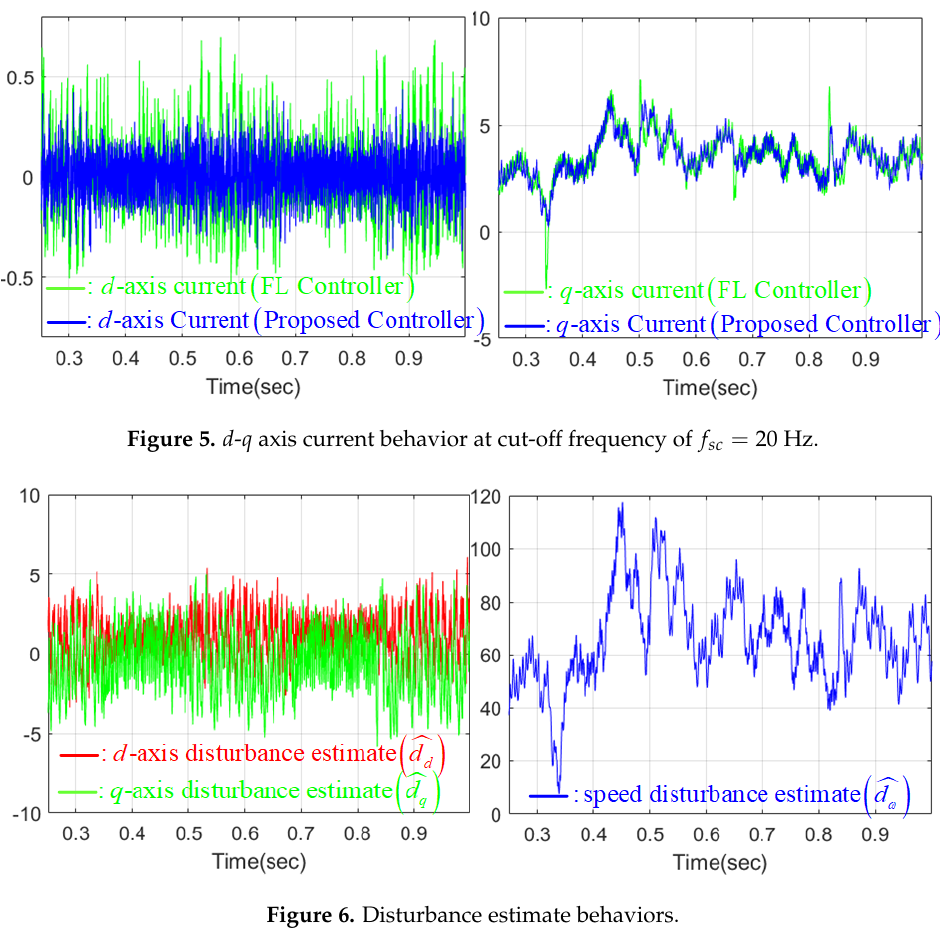
Figure 6. Disturbance estimate behaviors.